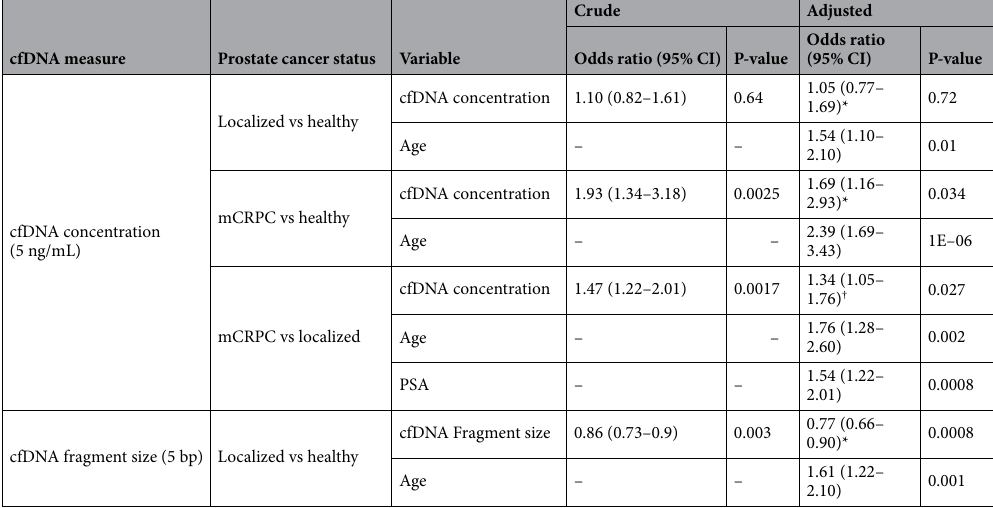
Table 2. Association between increase in cfDNA concentration (5 ng/mL) or in cfDNA fragment size (5 bp) and prostate cancer status. Results from crude univariate and adjusted multivariate logistic regression analyses (adjusted for age, and PSA when available). *Adjusted for age. † Adjusted for age and